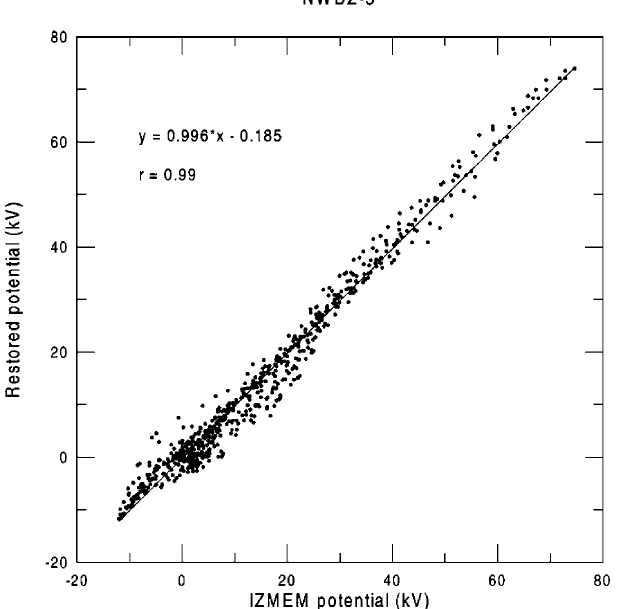
Fig. 4. Reconstructed electric potentials versus the IZMEM/DMSP potentials in the northern winter polar cap for southward IMF ( B x (cid:136) 0, B y (cid:136) 0, B z (cid:136) (cid:255) 5 nT)